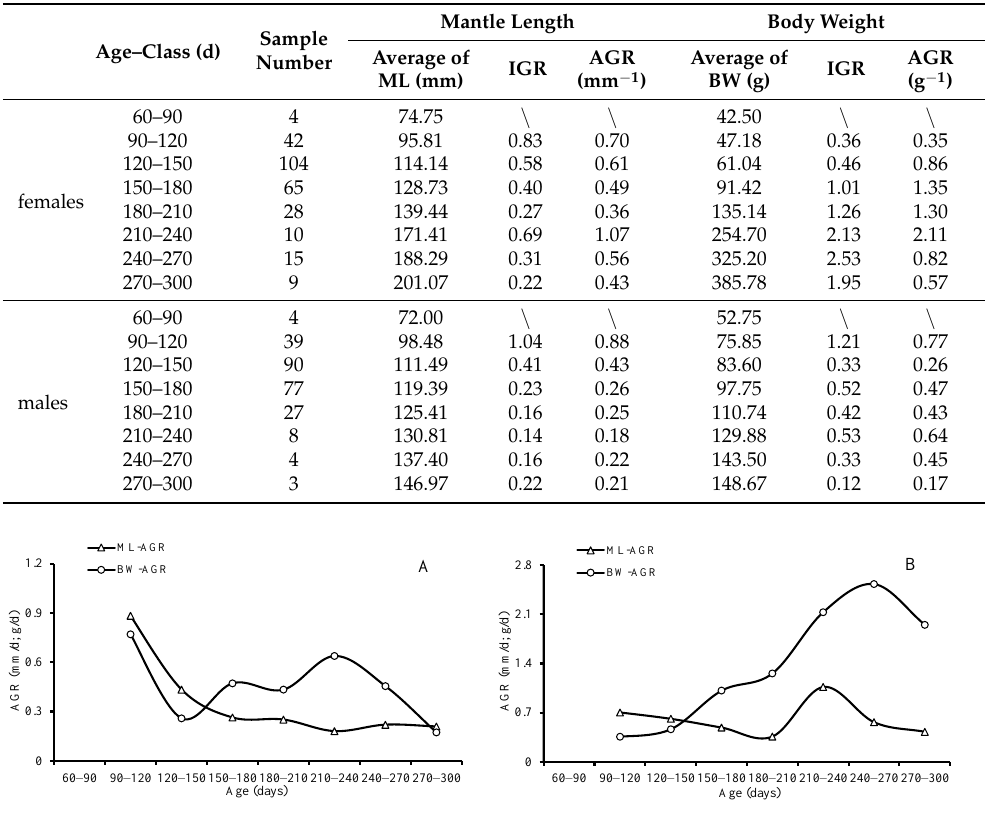
Figure 9. Absolute growth rates (AGRs) of mantle length and body weight for S. oualaniensis: ( A ) males, and ( B ) females.